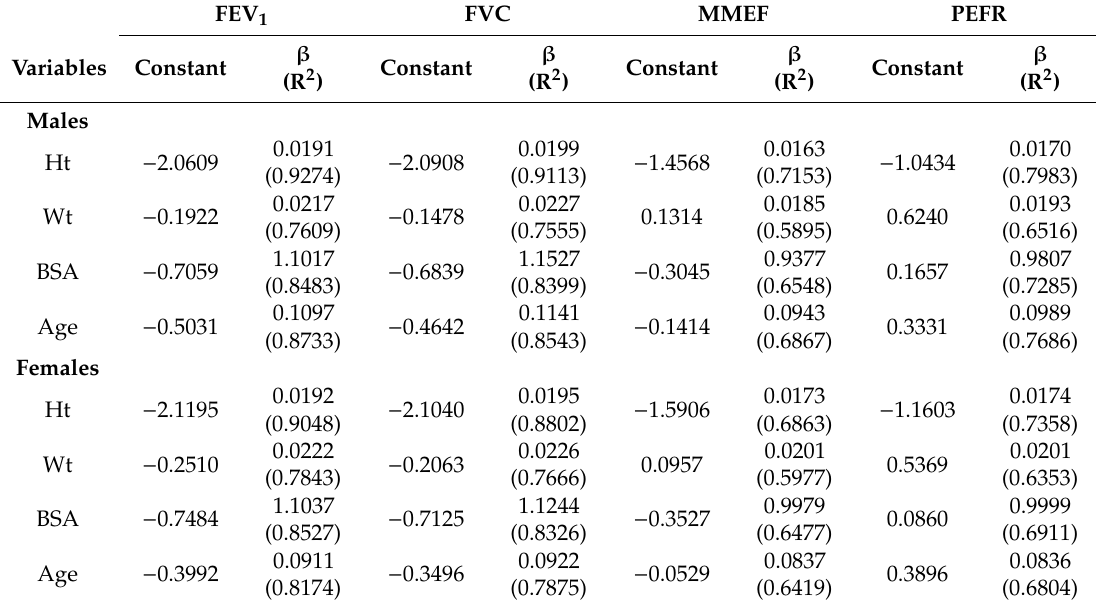
Table 2. Simple regression coe ffi cients for predicting the spirometric